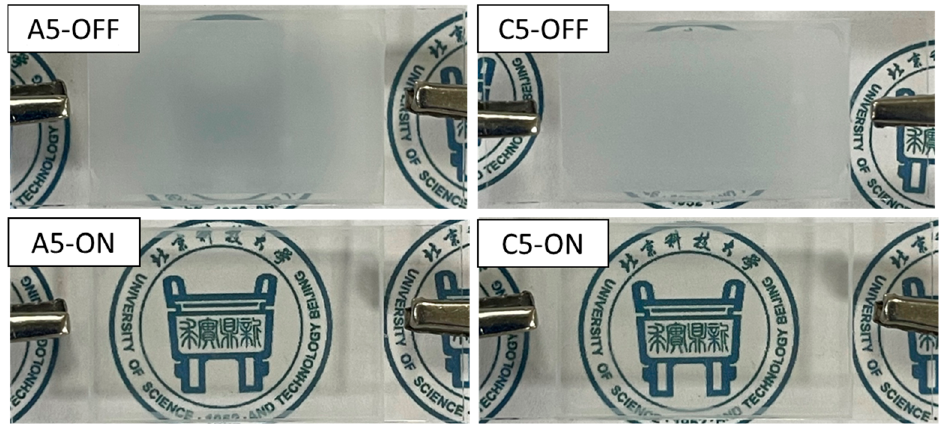
Figure 9. Actual pictures of samples A5 and C5.